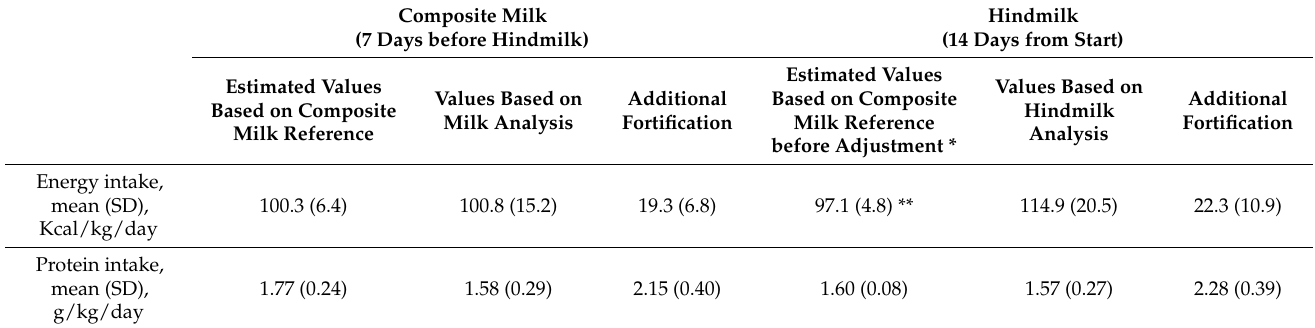
Table 3. Estimated and actual intakes in the week before and the two weeks after feeding fortified